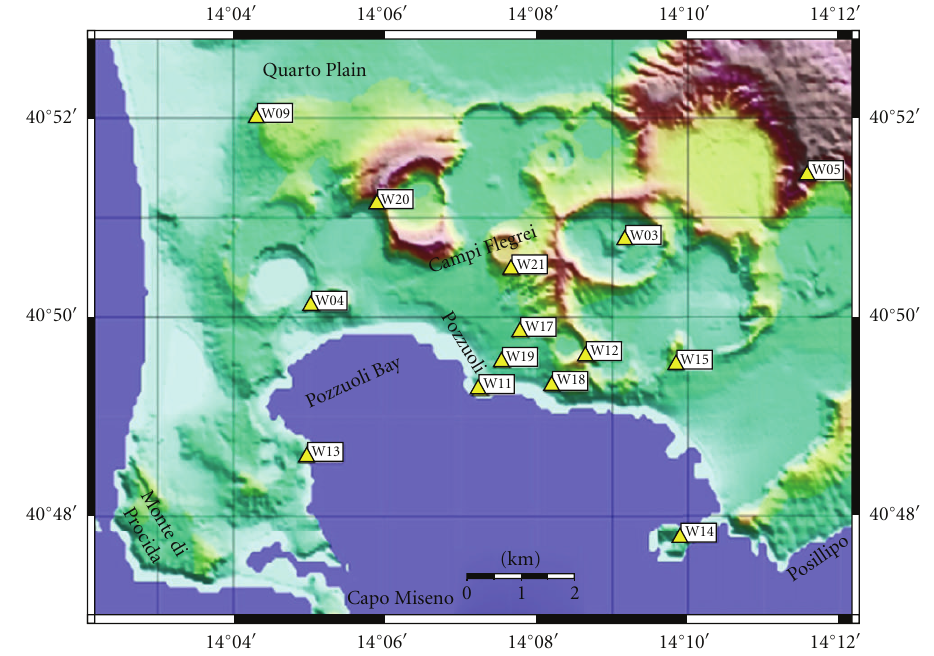
Figure 2: Map of the Campi Flegrei area with the location of the 1982–1984 campaign seismological stations.